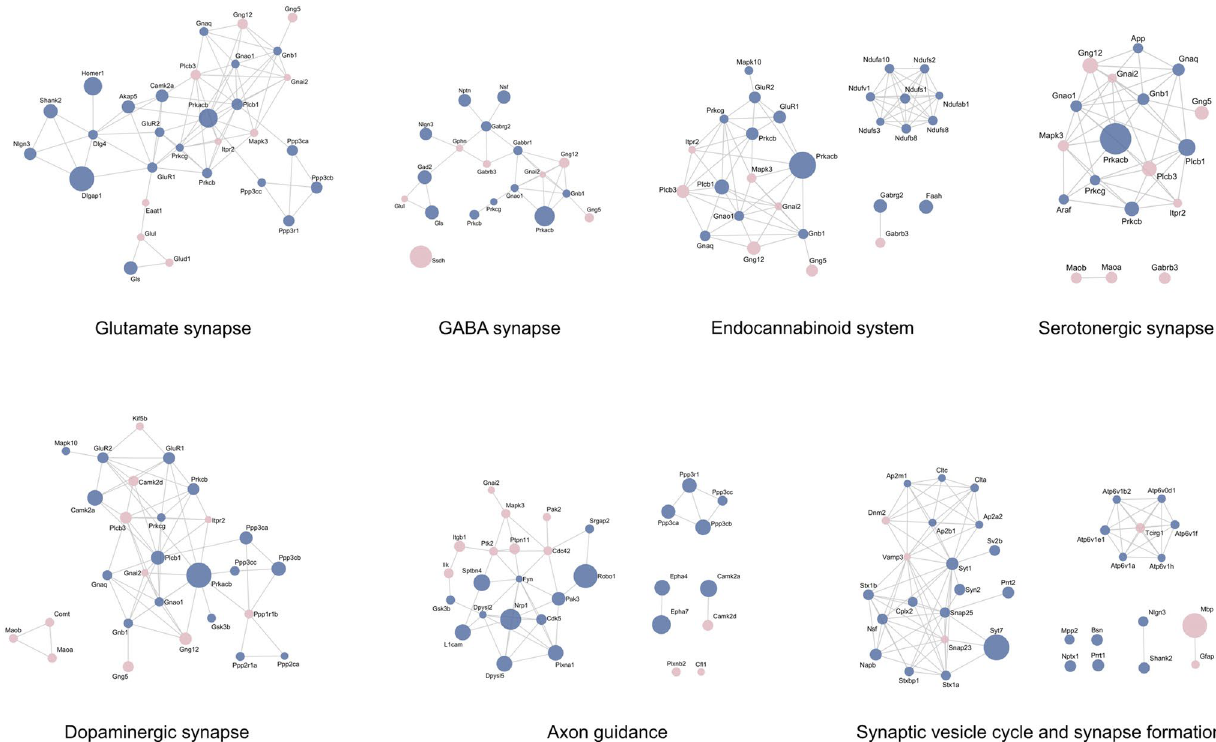
Figure 4. Molecular interaction network of proteins differently abundant between females and males underlying neurotransmission pathways and synapse function. Node colors indicate increased abundant proteins in female (pale pink) and male (blue) hippocampus, and node size indicates different levels of fold changes relative to each individual network. Protein–protein interaction analysis of significantly changed proteins in the hippocampus was obtained using STRING and then mapped by using Cytoscape 3.7.1. For more details, see Supplementary Dataset 3. Statistical analyses were performed by using Student’s t test followed